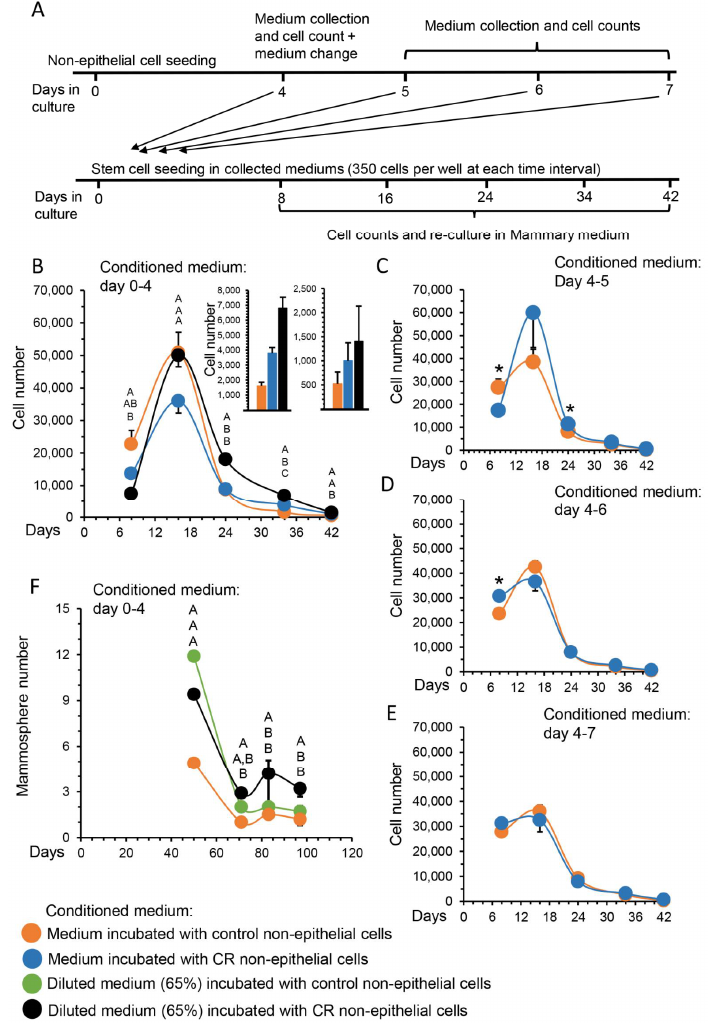
Figure 2. Time-course analysis confirming the involvement of non-epithelial cells in transducing the latent effect of calorie restriction (CR) on mammary epithelial stem cell (MaSC) self-renewal. ( A ) Scheme of the experimental procedure for the propagation rate analysis. Non-epithelial cells were cultured for 4 days in mammary medium (17,000 cells/well in 96-well plate) and conditioned medium was collected as described in Figure 1A. For the first 8 days of culture, 100 μL conditioned medium was supplemented to 350 freshly prepared MaSCs per well. Cells were trypsinized, counted and re-seeded at the equal concentration of 350 cells/well in 100 μL fresh mammary medium to confirm a latent CR effect. This procedure was repeated at each of the indicated times when cell propagation was analyzed. To confirm a time-limited carryover effect, conditioned medium was also collected between days 4 and 7 of the culture period and used to analyze MaSC propagation rate. ( B ) Time-course analysis of propagation rate in MaSC-initiated cultures. Points represents mean ± SEM of cell number, N = 5. Inset: Cell number on days 34 and 42 of culture. Statistical analysis was performed by one-way ANOVA (Tukey–Kramer means comparison). Different letters above the chart indicate statistically significant ( p < 0.05) differences in the comparison of each value to its counterpart values. ( C – E ) Propagation rate was analyzed with conditioned medium collected at later dates from the non-epithelial cell culture. Points represents mean ± SEM of cell number in five replications. A t -test was performed to identify statistical differences between treatments. * p < 0.05. ( F ) Analysis of mammospheres generated from MaSC-initiated cultures that were supplemented with conditioned medium of non-epithelial cells from ad libitum-fed and CR-treated mice. Points represent mean ± SEM of five replications. Different letters above the chart indicate statistically significant ( p < 0.05) differences in the comparison of each value to its counterpart